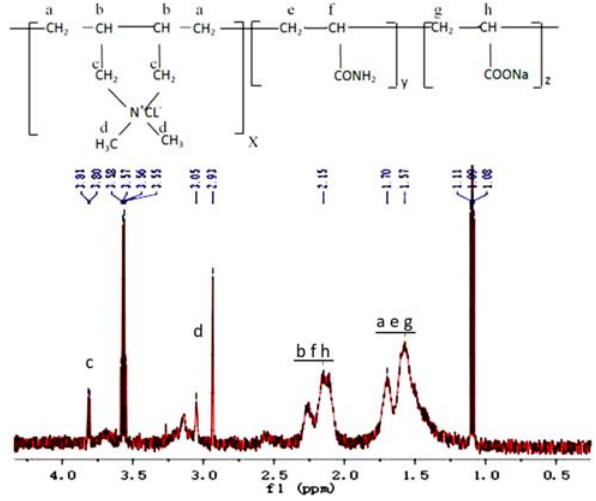
Figure 2: 1 H NMR spectra of PDAA.